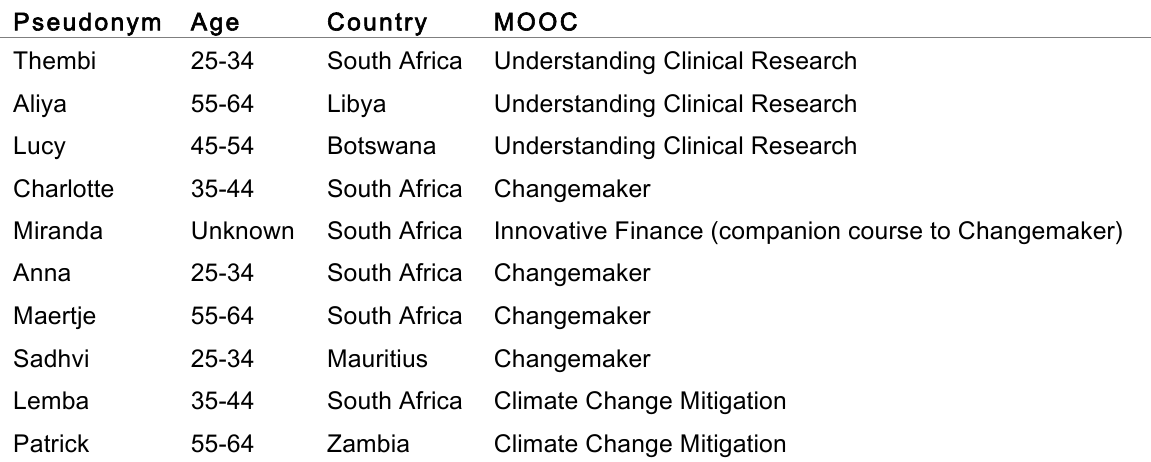
Table 1: Biographical information about the interviewees Pseudonym Age